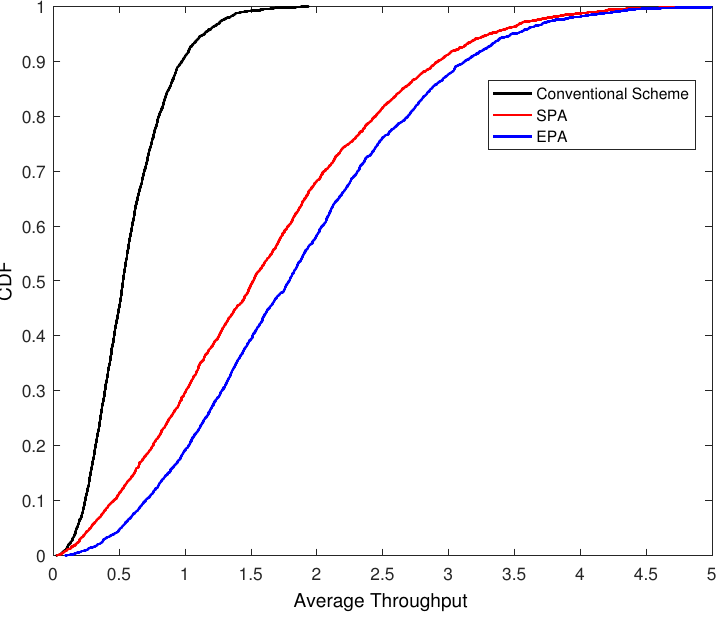
Figure 9. The CDF of the average uplink rate when M = 64 using